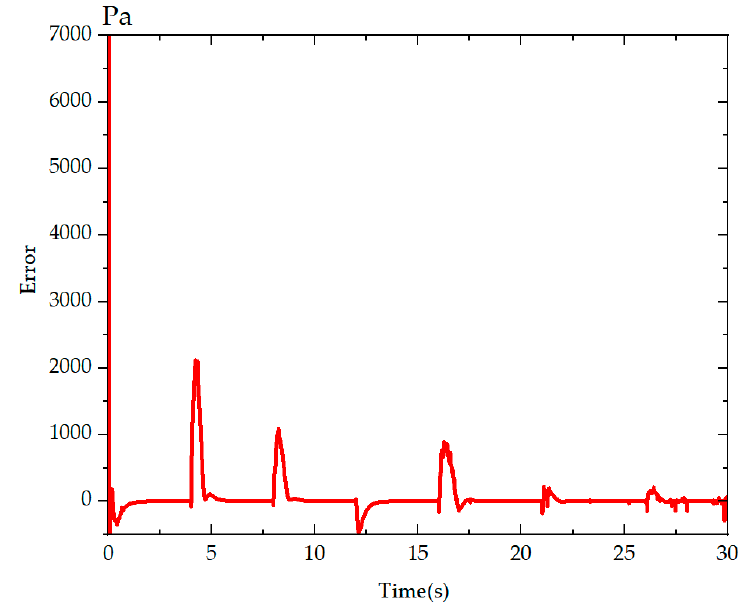
Figure 3. Estimation error of ESO.